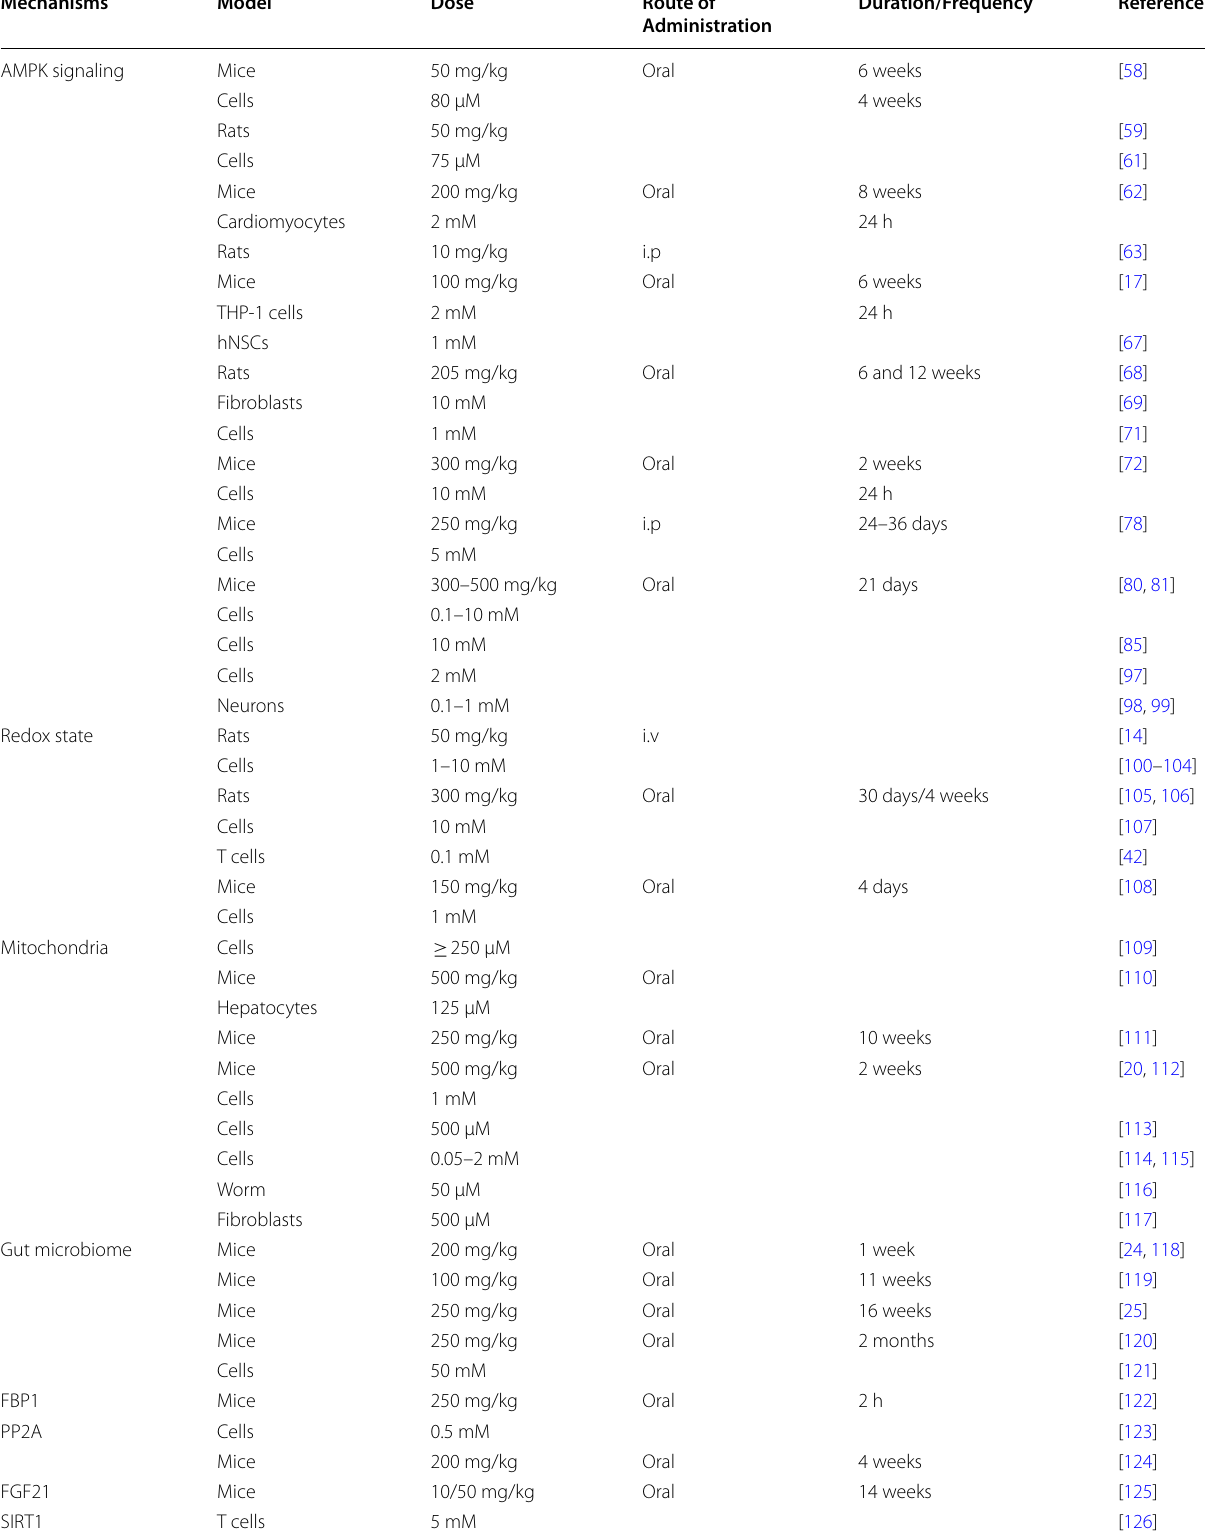
Table 1 Dosages of metformin in In vitro and In vivo experiments